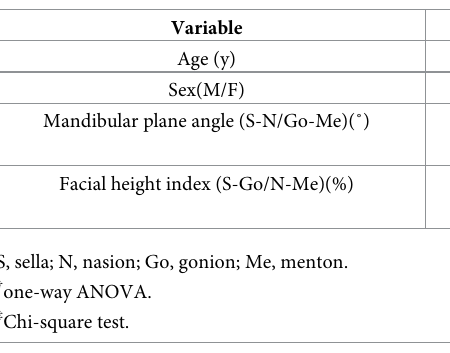
Table 1. Patient